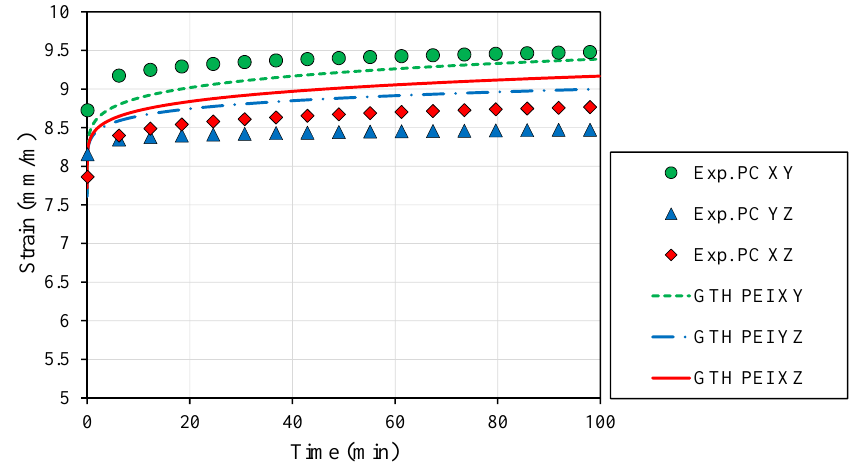
Figure 5. Creep curves for different part build orientations at RT for Polycarbonate (PC, markers) [27] and Polyetherimide (PEI, dashed lines) under 16 MPa. The GTH model was used with orientation-dependent coefficients to predict PEI behavior.